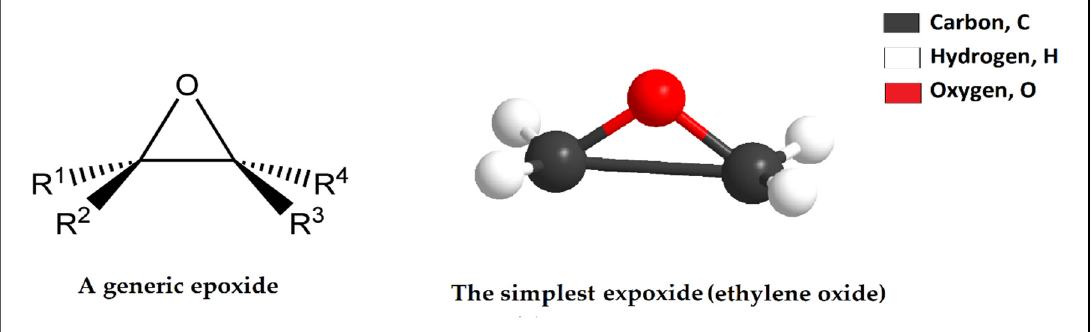
Figure 5. Chemical structure of the epoxide and ethylene oxide.